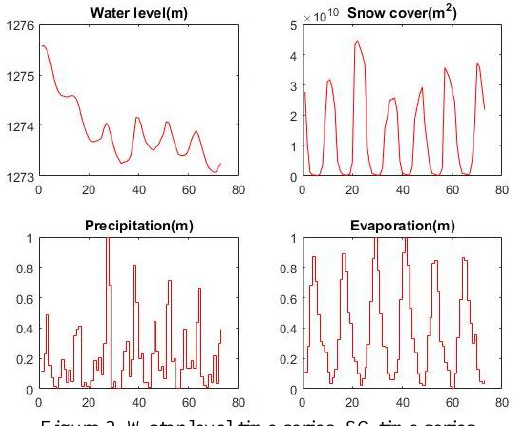
Figure 3. Water level time series, SC time series,